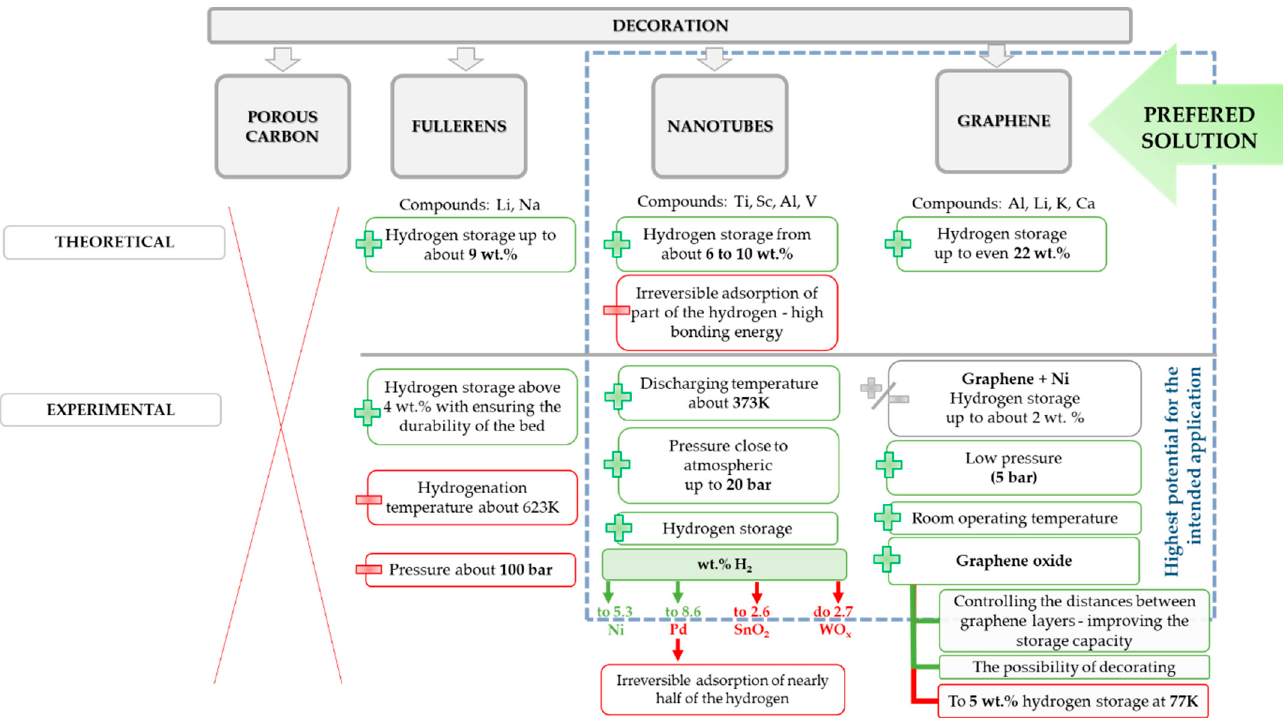
Figure 9. Summary of solutions for carbon-based materials decoration to upgrade their performance for the purpose of